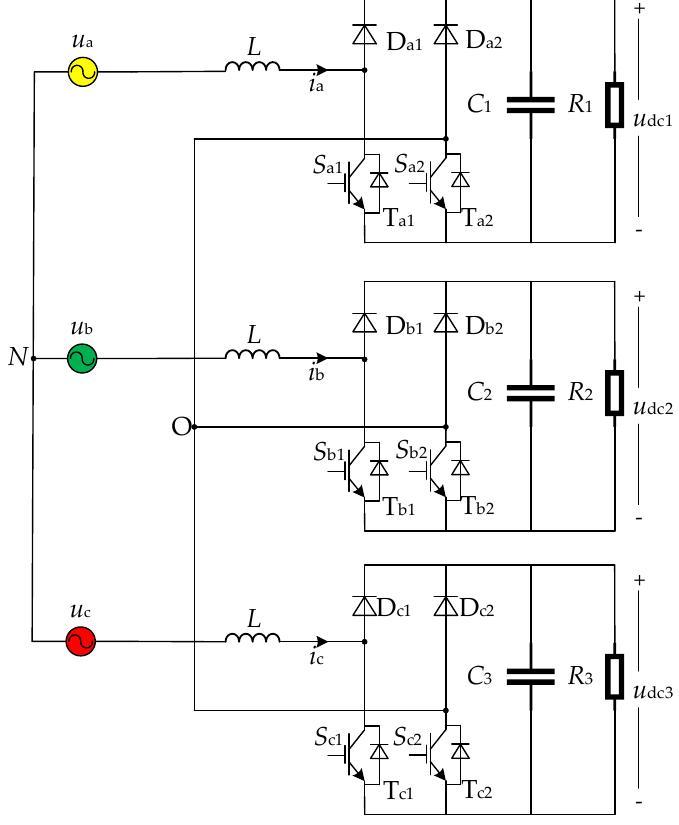
Figure 1. Topology of three phase Y − connected bridgeless rectifier.